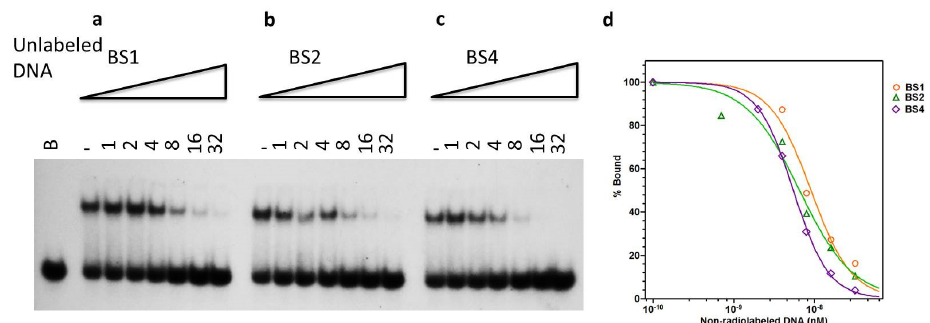
Figure 4. EMSA challenge assay verifies the E2 hierarchy of binding. ( a – c ) Challenge experiments with oligonucleotides containing individual E2 binding sites, as indicated, and titration of the E2 and 32 P-BS1 complex formation. The E2 protein and 32 P-BS1 concentrations remained constant. The lane that contained no E2 is marked as B. The positive control in the lane with E2 but no added competitor was represented by (-). ( d ) Quantitative analysis of challenge assay in ( a – c